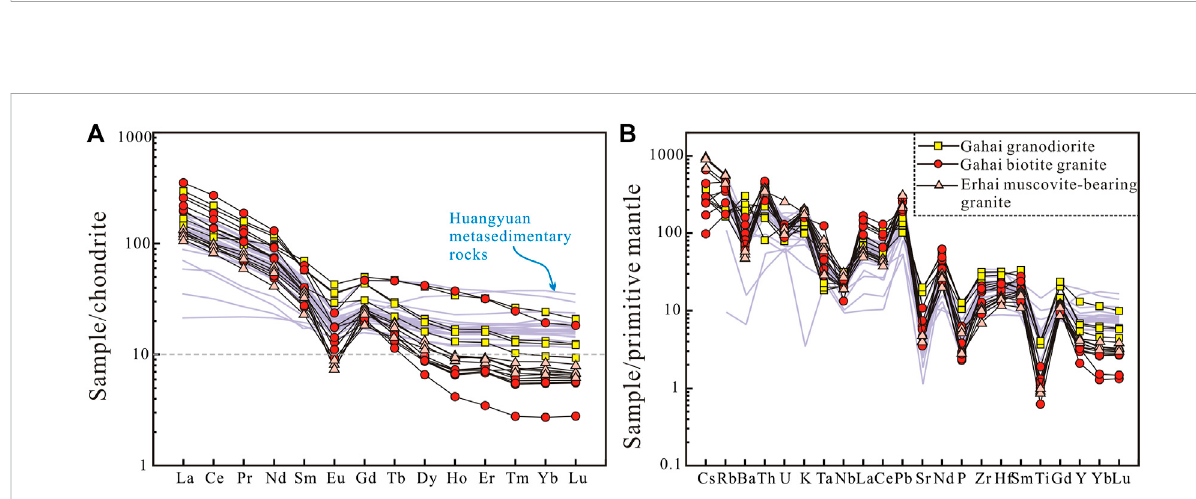
FIGURE 6 Chondrite-normalized REE patterns (A) and primitive-mantle-normalized trace element variation diagrams (B) of rocks from the Gahai and Erhai plutons. The data for chondrite and primitive mantle are from Boynton (1984) and McDonough and Sun (1995), respectively. The data for the Huangyuan Group metasedimentary rocks are from Li et al.